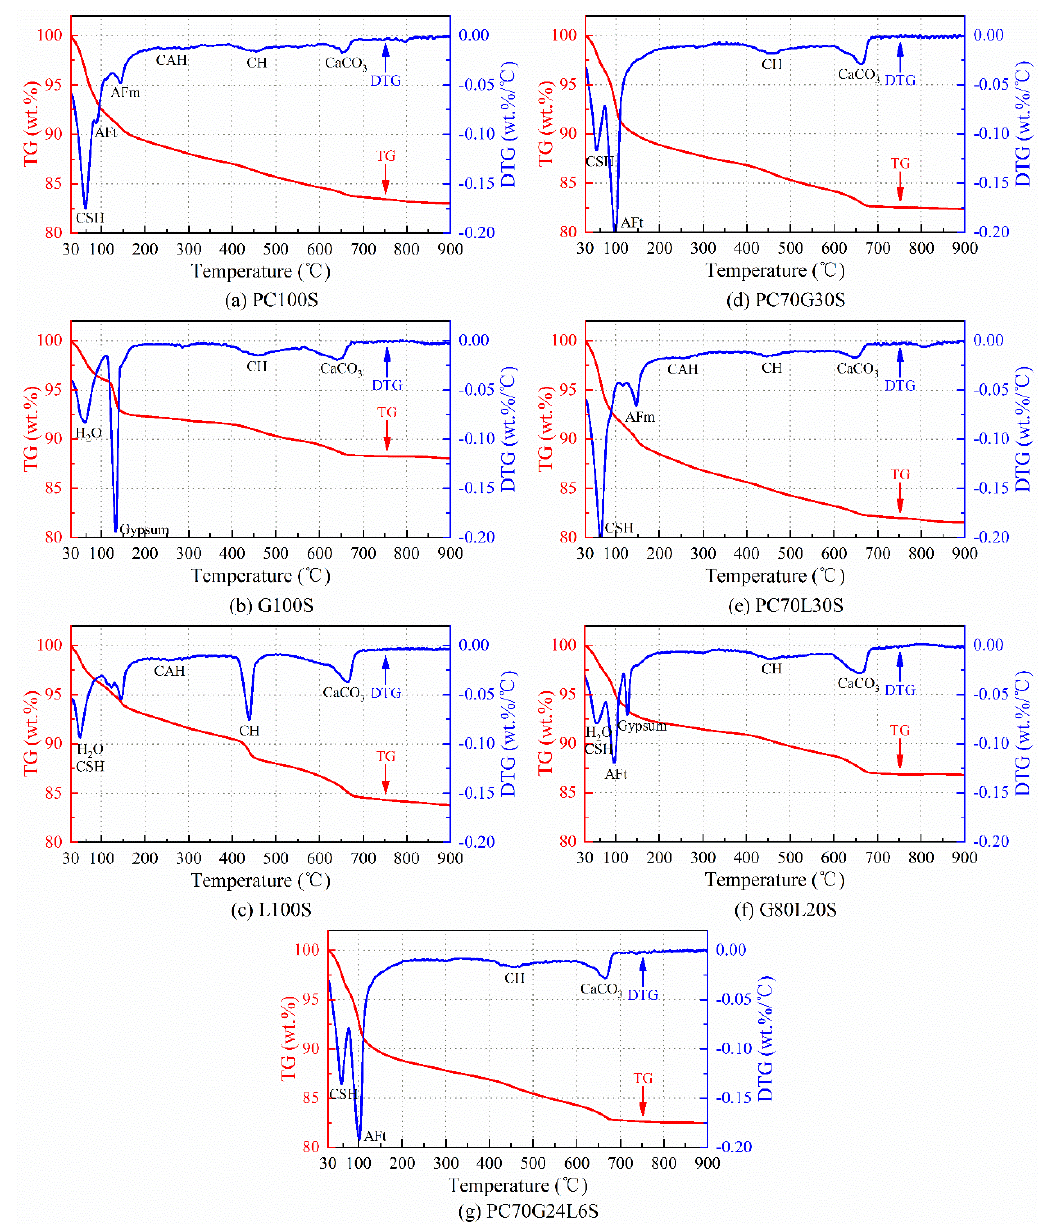
Figure 5. Thermogravimetry and derivative thermogravimetry ( TG–DTG) curves of the stabilized soil samples.